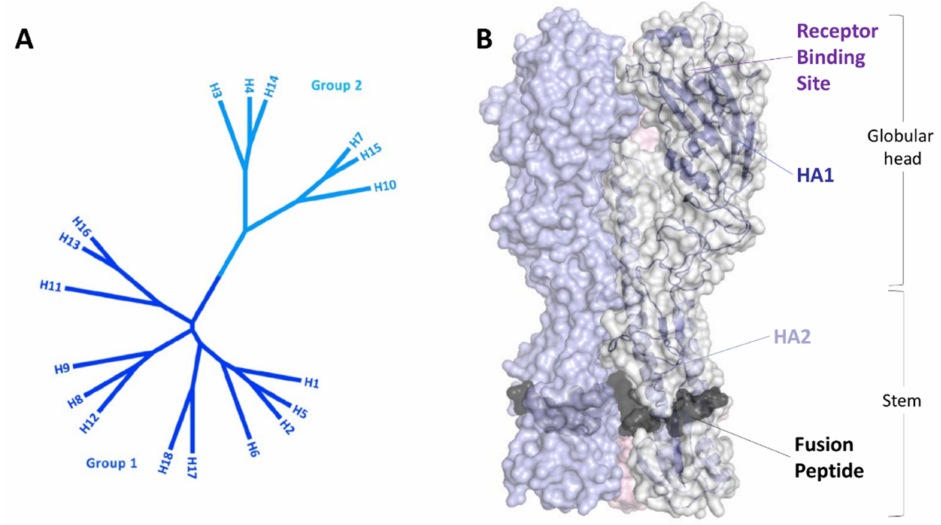
Figure 3. ( A ) Phylogenetic tree and ( B ) structure of